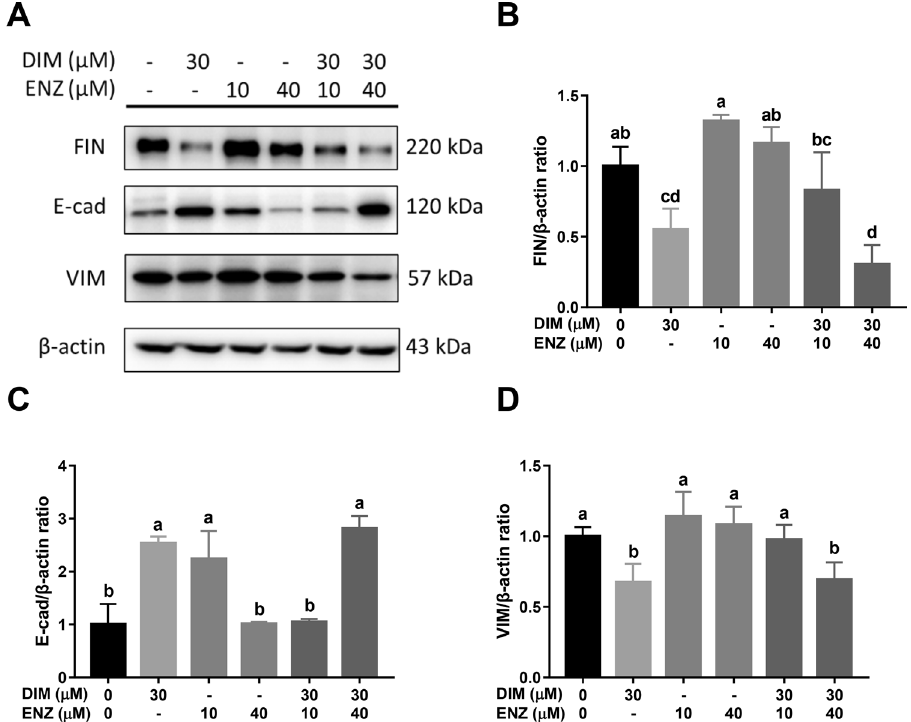
Figure 9. DIM and ENZ treatment alter EMT-related protein expressions in 22Rv1 cells at 48 h. Representative western blot image ( A ); quantitative results for FIN ( B ), E-cad ( C ), and VIM ( D ). DIM 3,3 ′ -diindolylmethane; ENZ enzalutamide; VIM Vimentin; FIN Fibronectin; E-cad E-cadherin. Values are presented as means ± SD. a,b,c,d Bars without the same letters at the top indicate statistically-significant differences between treatments when compared with each other (one-way ANOVA, Duncan’s new multiple range test, p <